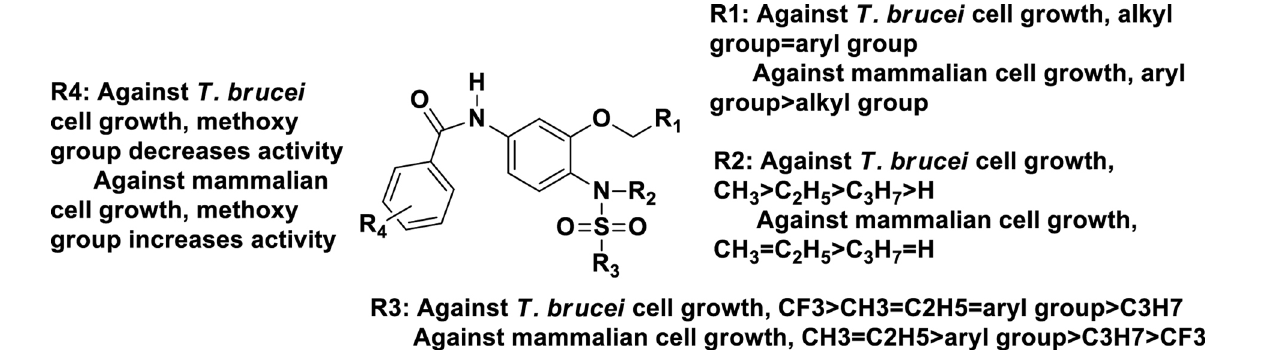
Fig 2. SAR results of the anti-mammalian cell growth activity and anti- T . brucei growth activity of the sulfonamide tubulin inhibitors.